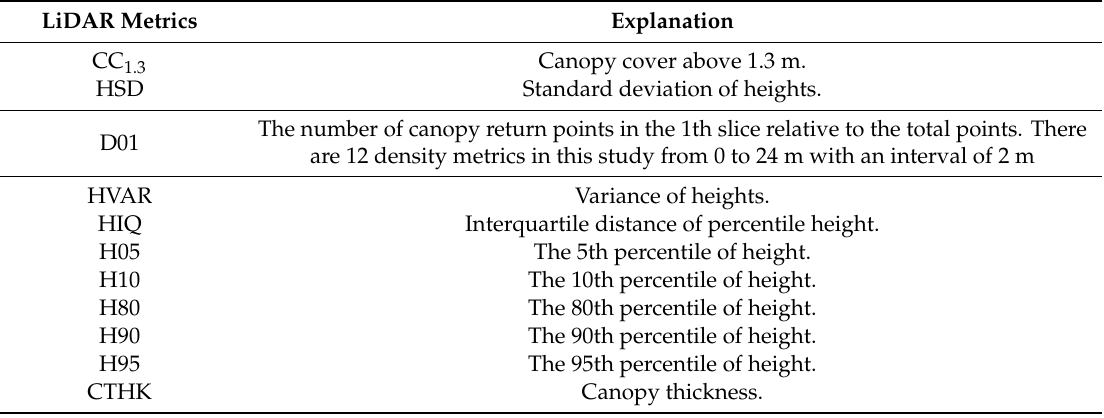
Table 3. List of the selected light detection and ranging (LiDAR)